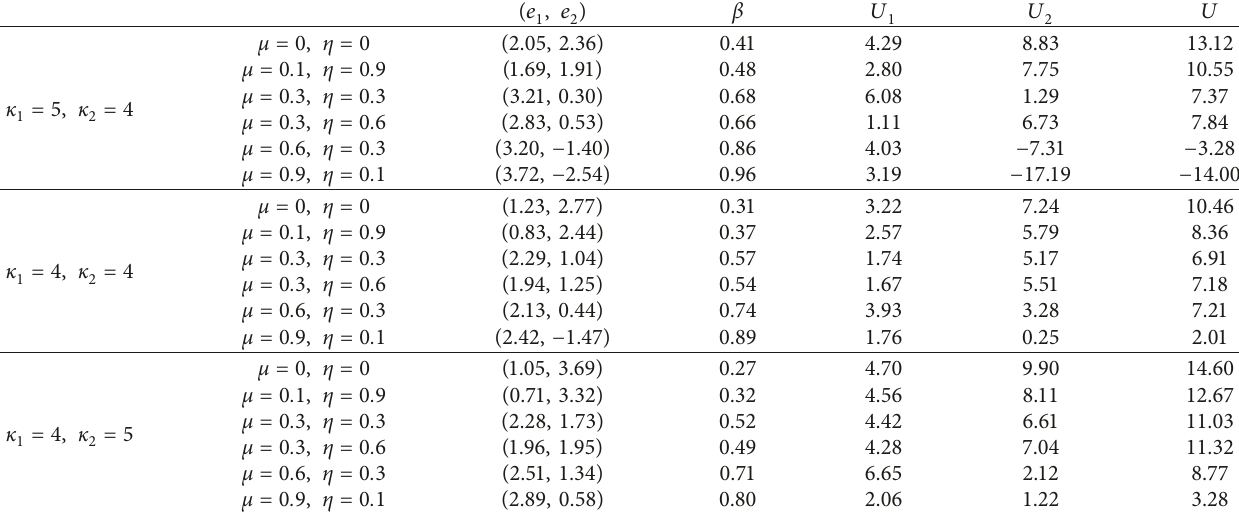
Figure 5: Effects of coefficients of converting conflicts to benefit and the loss caused by conflicts on benefits. (a) Effects of (b) Effects of on U 2 . Table 1: The results of conflict decision model between the owner and contractor under different situations.